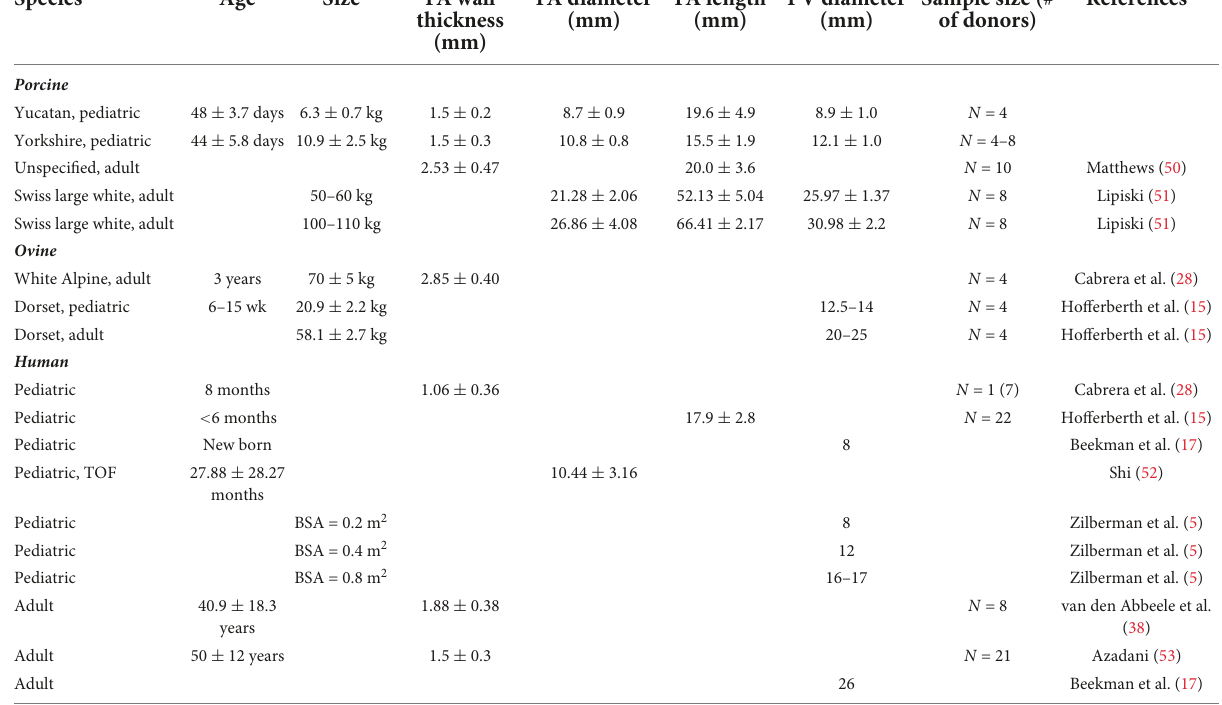
TABLE 2 Comparison of measurements across species and ages.